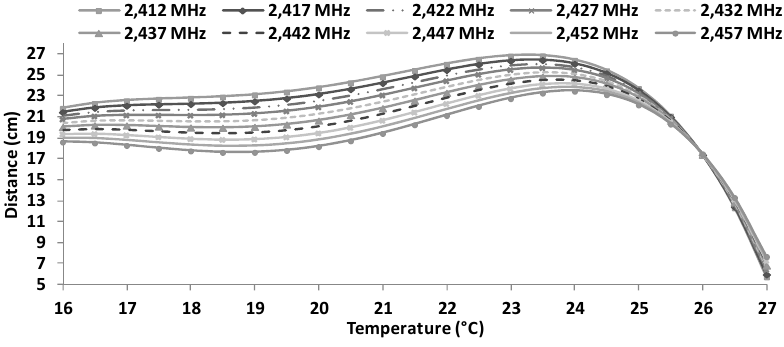
Figure 21. Estimated maximum distances for QPSK modulation.